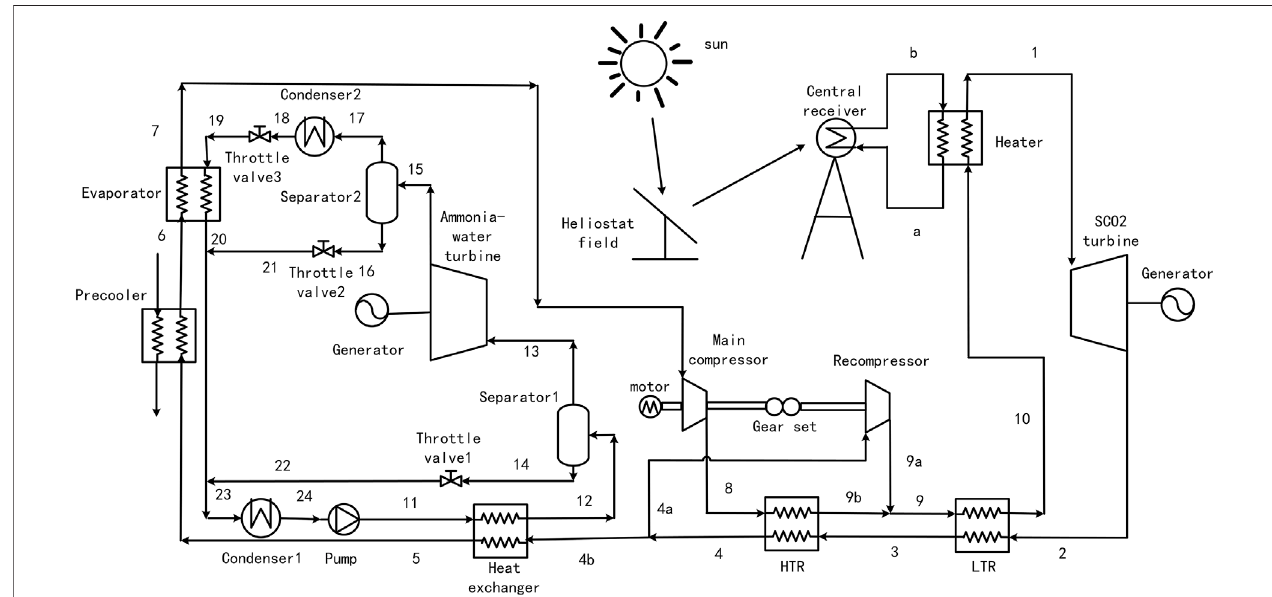
FIGURE 1 | Flow scheme of proposed RSCO 2 -ACPC